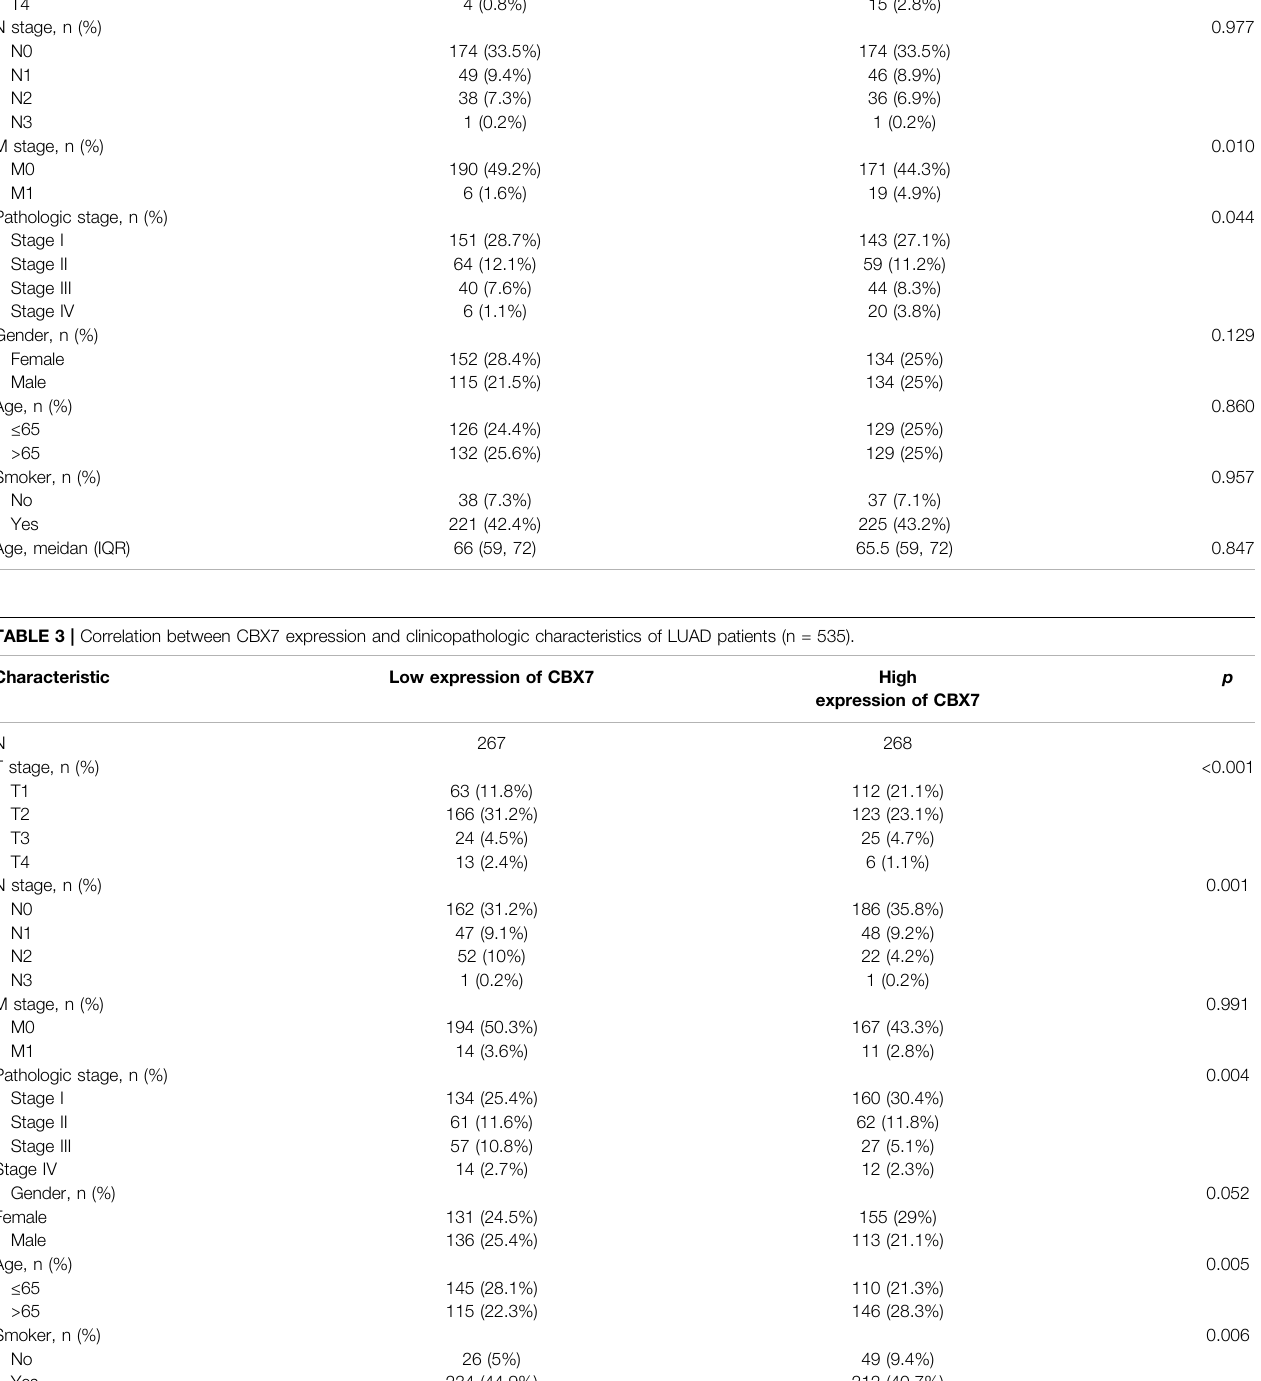
TABLE 2 | Correlation between CBX5 expression and clinicopathologic characteristics of LUAD patients (n (cid:1) 535). Characteristic